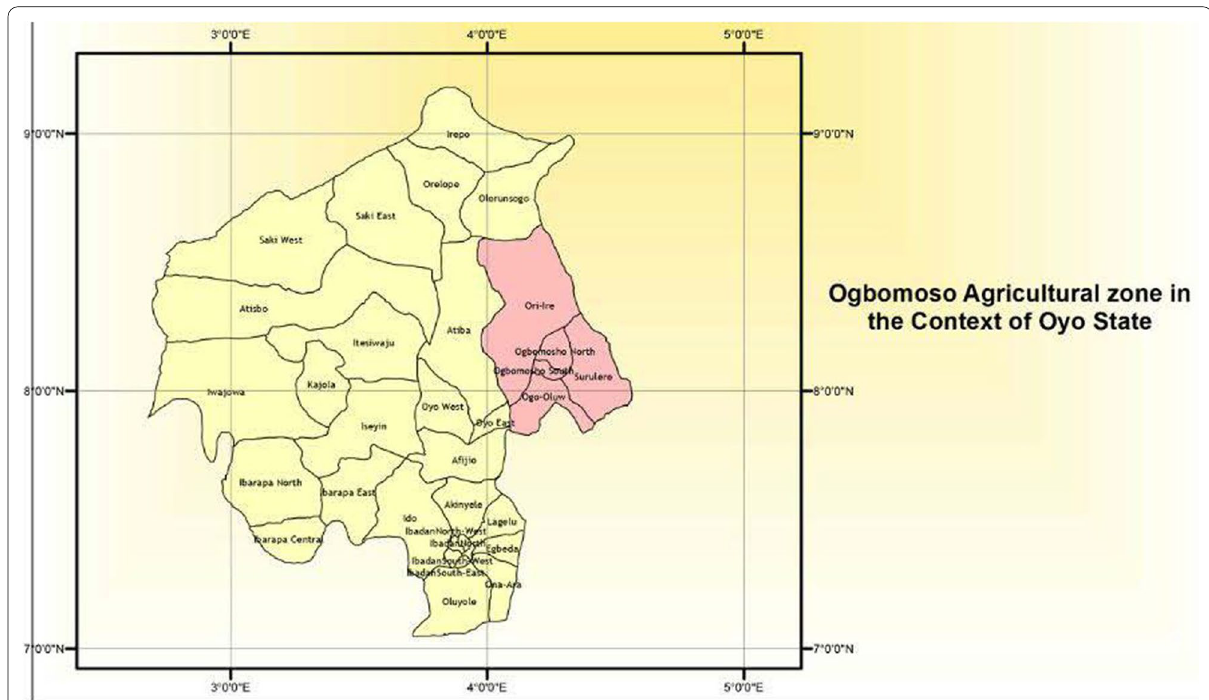
Fig. 2 Map of the study area under Ogbomoso Agricultural Zone [adapted from Ewetola et al.